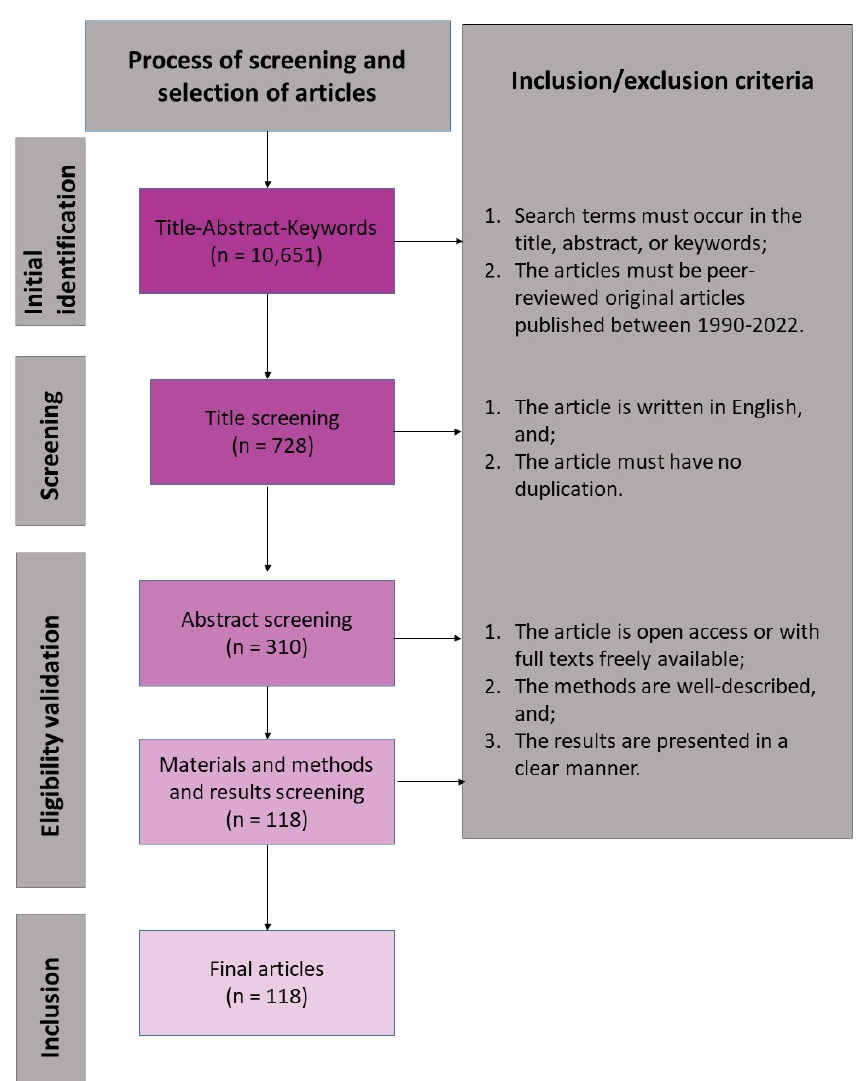
Figure 5. Preferred Reporting Items in Systematic Reviews and Meta-Analyses (PRISMA) flow diagram of inclusion and exclusion of peer-reviewed studies on seed dispersal in a changing environ- ment that was used for the present systematic review. The n denotes the number of articles identified and included through a five-step selection process.